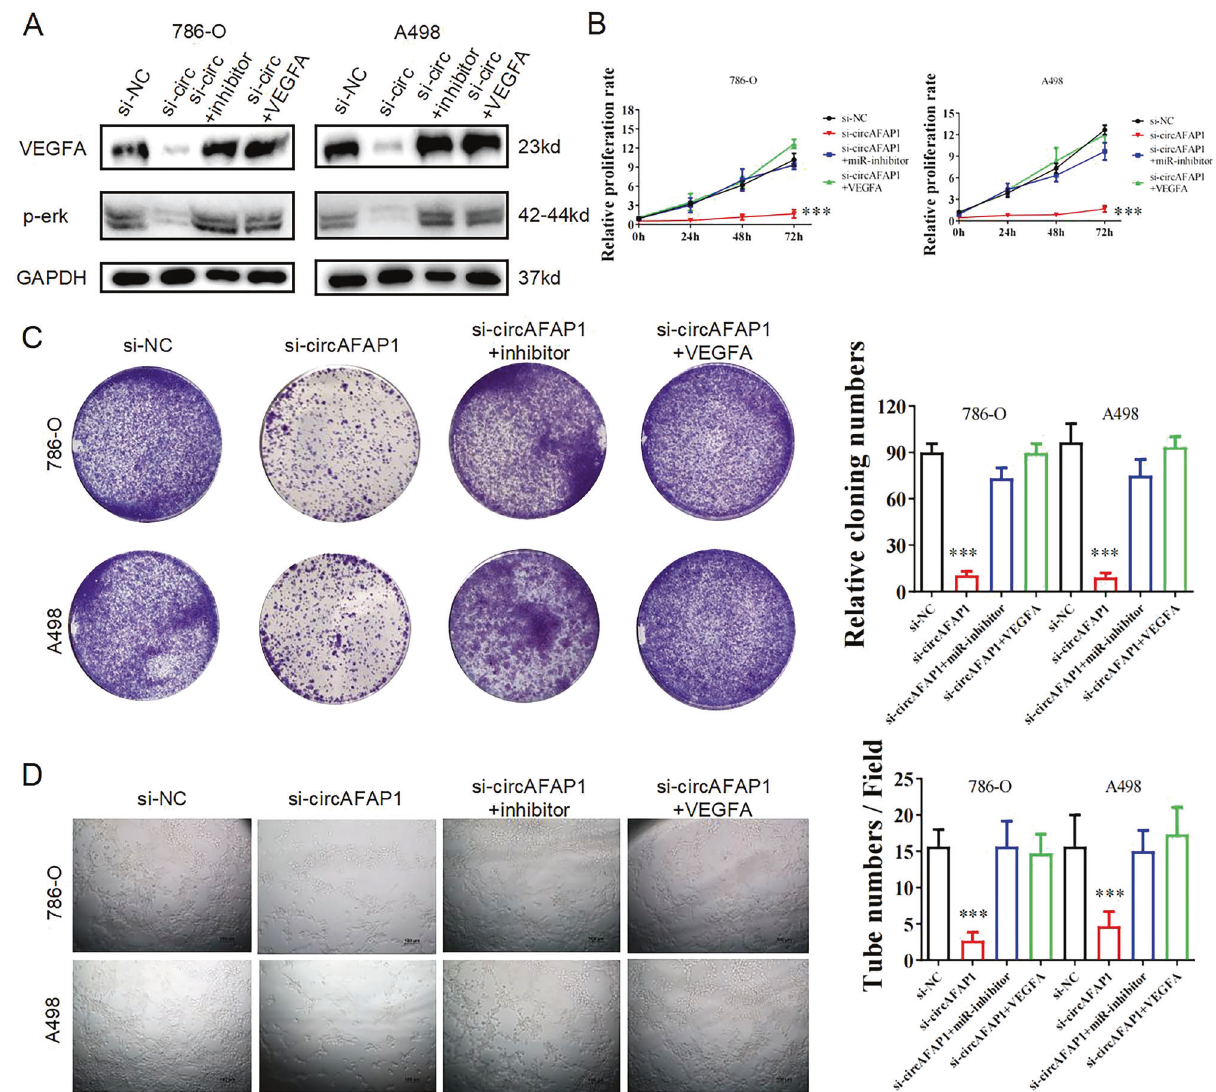
Fig. 4 Downregulation miR-374b-3p or overexpression VEGFA could restore proliferation and vascular formation in ccRCC cells after circAFAP1 silencing. A Western blot displayed the VEGFA and p-erk levels in 786-O and A498 cells, both of which were transfected of scrambled siRNA (si-NC), si-circAFAP1 (si-circ), si-circAFAP1 + miRNA inhibitor (si-circ + inhibitor), or si-circAFAP1 + VEGFA overexpression plasmid (si-circ + VEGFA) respectively. GAPDH was used as the control gene. B , C CCK8 proliferation assays ( B ) and colony formation assays ( C ) were carried out to evaluate the proliferation ability. ***represents p < 0.001. D Tube formation assay was applied to measure the vascular formation ability after adding the supernatant of the relative ccRCC cells into HUVEC cells. ***represents p <